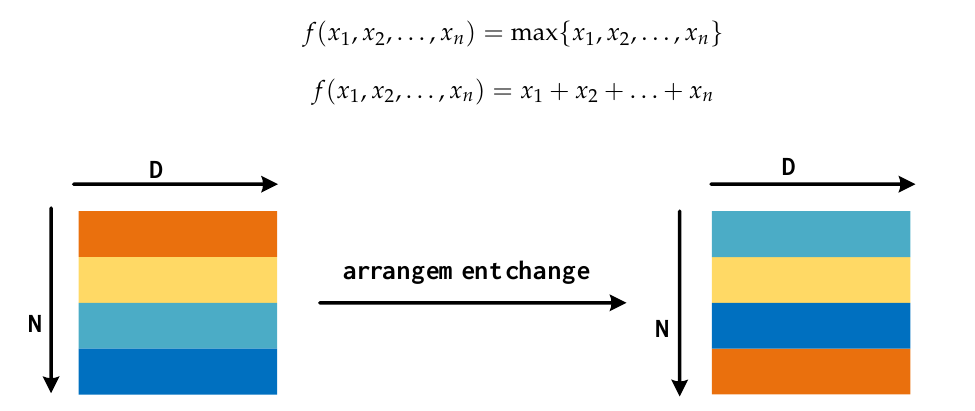
Figure 2. Permutation invariance of point clouds.